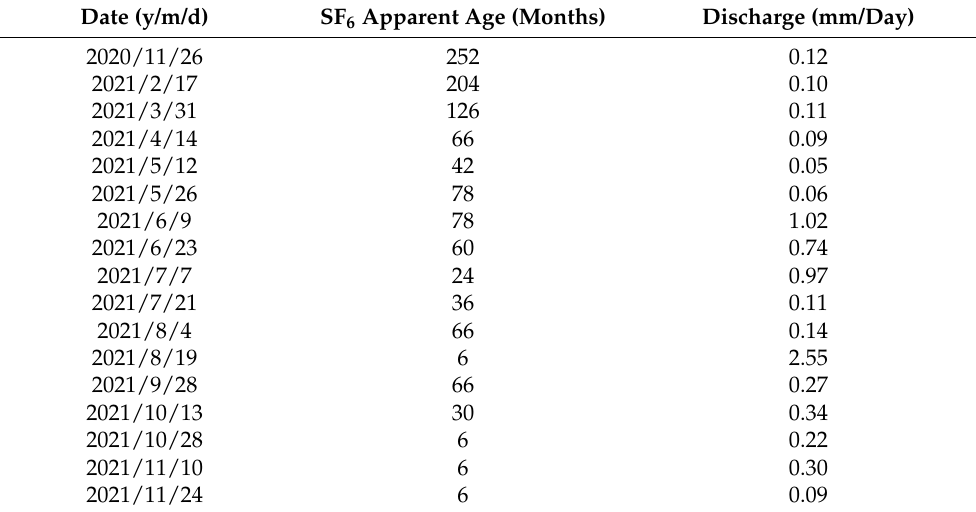
Table 1. Sampling dates, apparent SF 6 age of each sample (in months), and their daily discharges (in mm/day). The weighted average of the apparent ages is 39.1